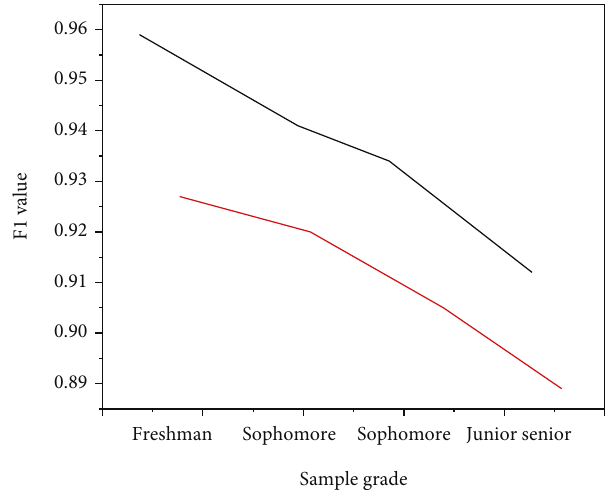
Figure 6: Comparison of label vector extraction e ff ects of samples of di ff erent